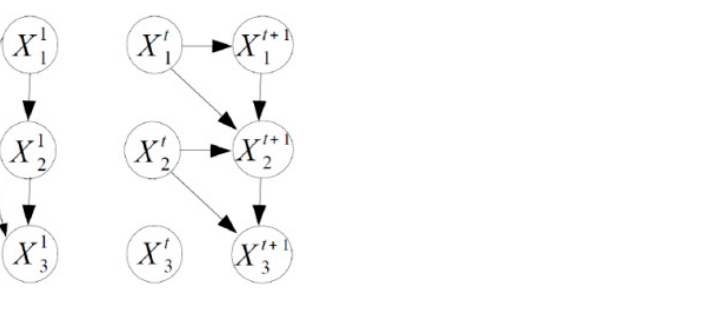
Table 5. Software packages benchmarking (* only if one discrete parent and no children).